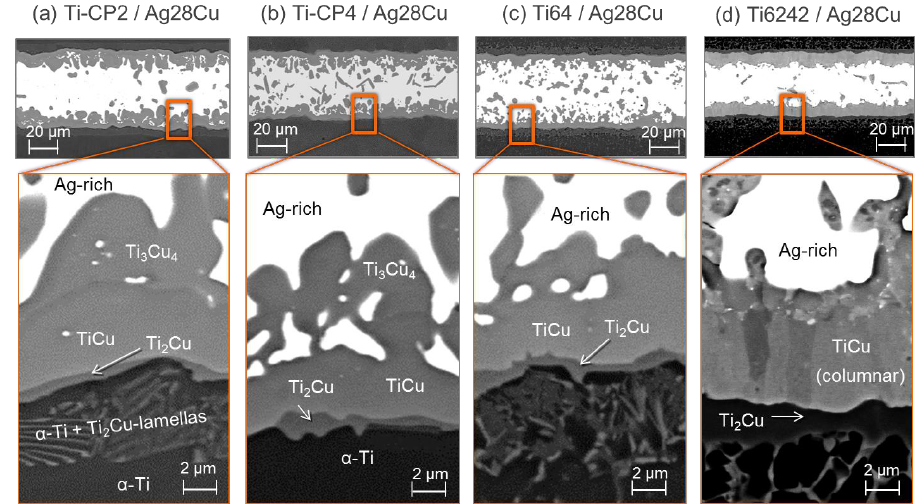
Figure 1. SEM micrographs of the brazing region for all investigated compounds: Ti-CP2 ( a ), Ti-CP4 ( b ), Ti64 ( c ) and Ti6242 ( d ). While alloying elements participate in the interface reactions, only phase designations according to the Ti-Cu phase diagram are presented here for legibility. Typical results of the EDS analysis are summarized in Table 2.